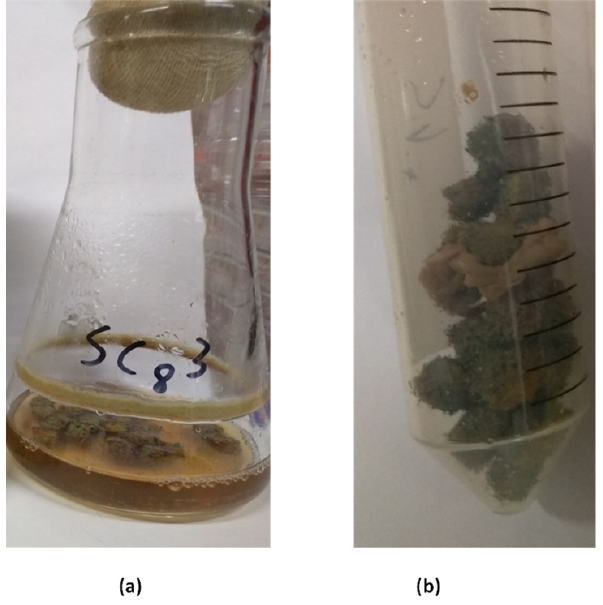
Figure 2. Color of biomass obtained under submerged fermentation conditions with mycelium immobilization on nylon sponge: ( a ) culture medium D after 5 days; ( b ) inert support (12 days) after culture medium filtration.